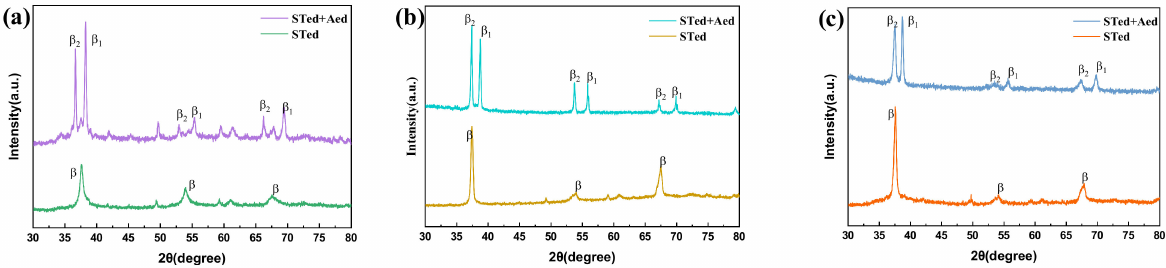
Figure 4. XRD patterns of the three alloys after solution treatment at 1173 K for 3 h and age treatment at 973 K for 6 h: ( a ) TZT1, ( b ) TZT2 and ( c )